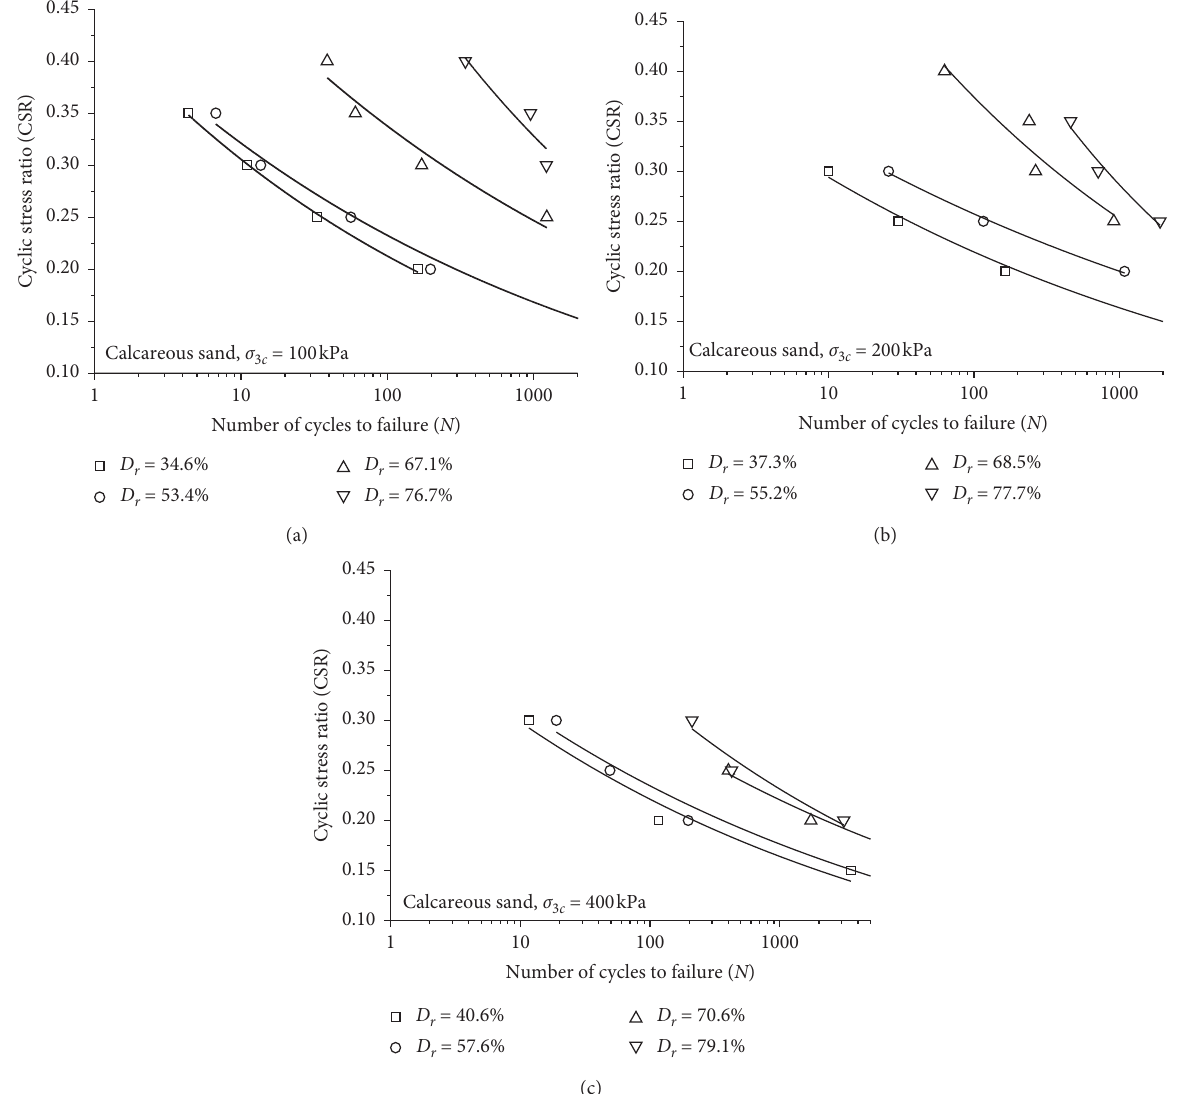
Figure 8: Effect of D